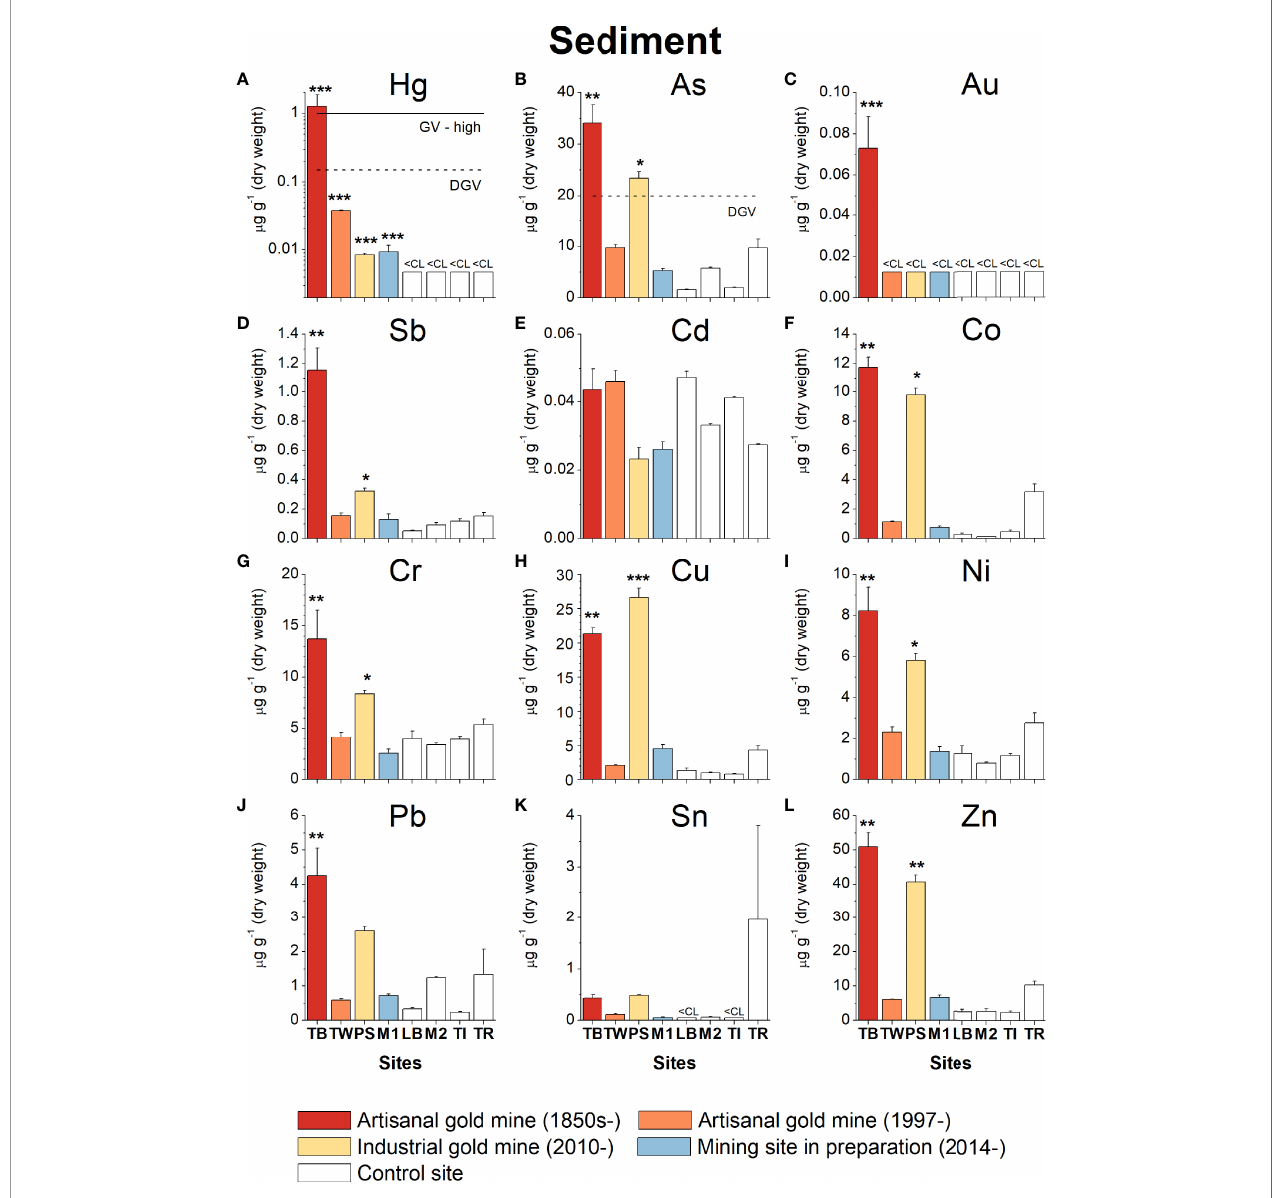
FIGURE 2 | Mean concentrations (± s.e.) of Hg (A) , As (B) , Au (C) , Sb (D) , Cd (E) , Co (F) , Cr (G) , Cu (H) , Ni (I) , Pb (J) , Sn (K) and Zn (L) in surface sediment at each study site (TB, Totok Bay; TW, Talawaan River; PS, Pantai Surabaya; M1, West Bangka mangroves; LB, Lihunu Bay; M2, North-west Bangka mangroves; TI, Tumbak Island; TR, Tasik Ria Resort). Whenever possible, the default guideline value (DGV), i.e., the concentration below which there is a low risk of unacceptable effects occurring, and the ‘ upper ’ guideline value (GV-high), i.e., the concentration over which adverse effects are expected, from Simpson et al. (2013), were reported (CL, critical limit). Impact sites that differ signi fi cantly from controls are marked with asterisks: * p < 0.05; ** p < 0.01; *** p <